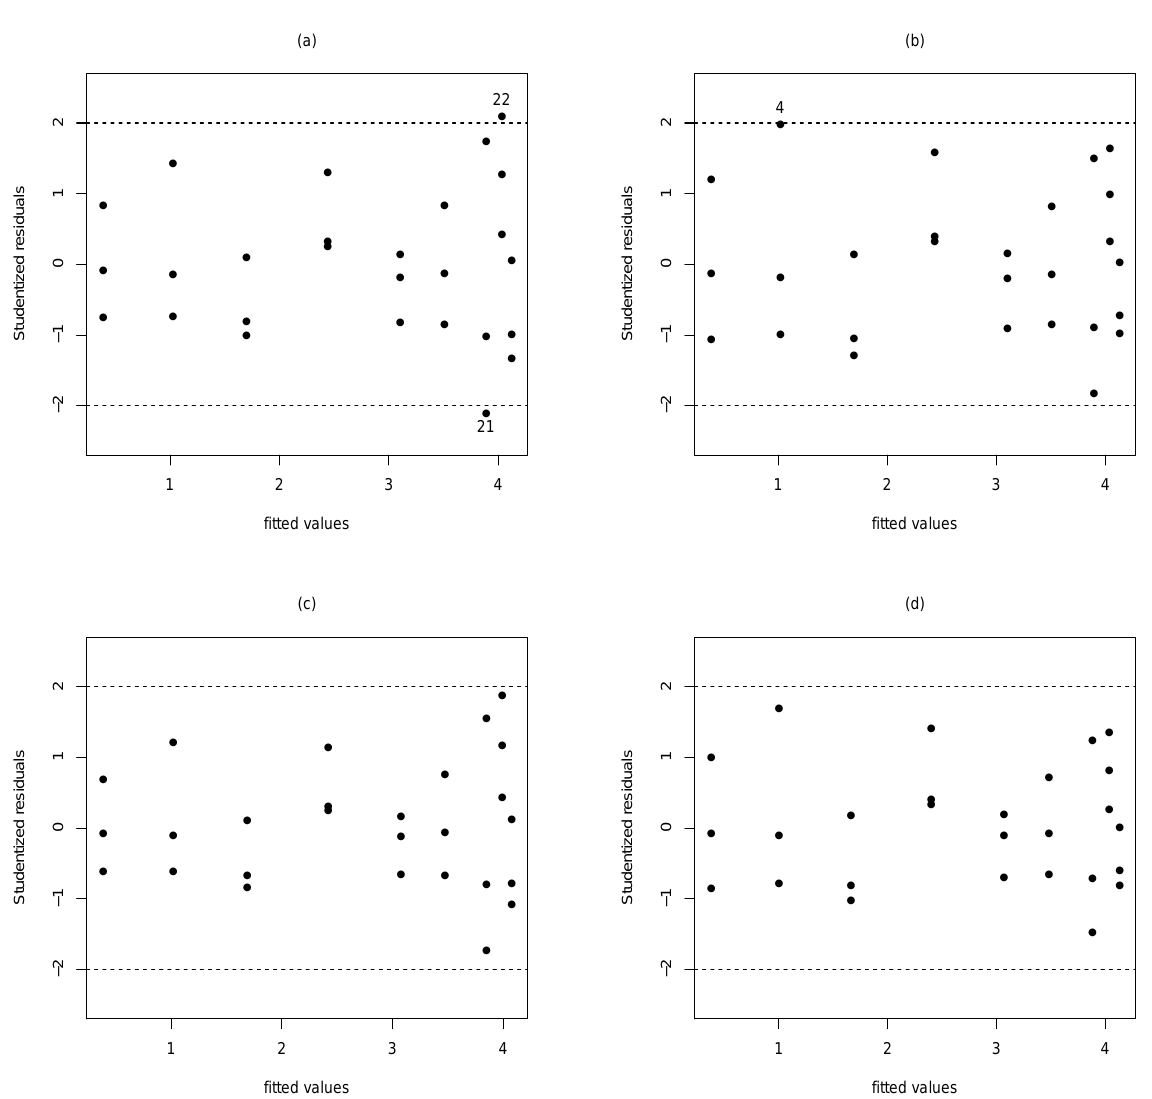
Figure 2. Calcium data. Plots of the studentized residual versus fitted values (a) homoscedastic normal model, (b) heteroscedastic normal model (c) homoscedastic Student- t model, (d) heteroscedastic Student- t with 𝜈 = 4 model.